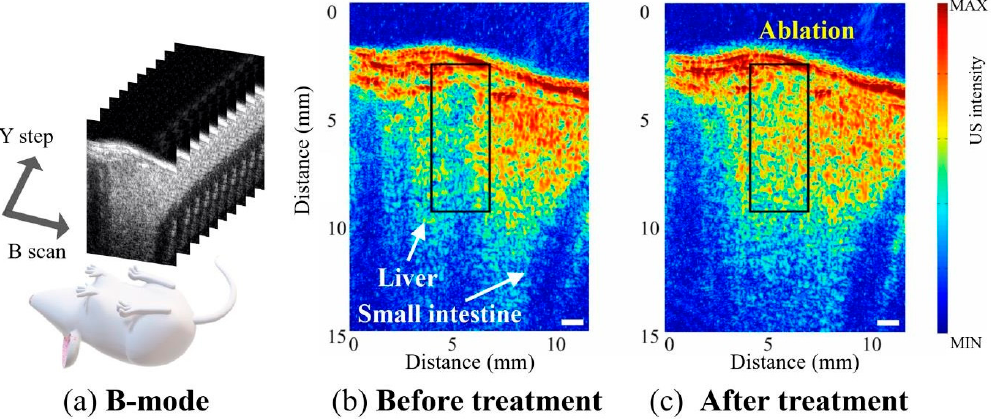
Figure 8. In vivo B-mode imaging. ( a ) Schematic of the B-mode imaging. Mouse bone and liver were imaged with high frequency ultrasound before ( b ) and after ( c ) treatment.